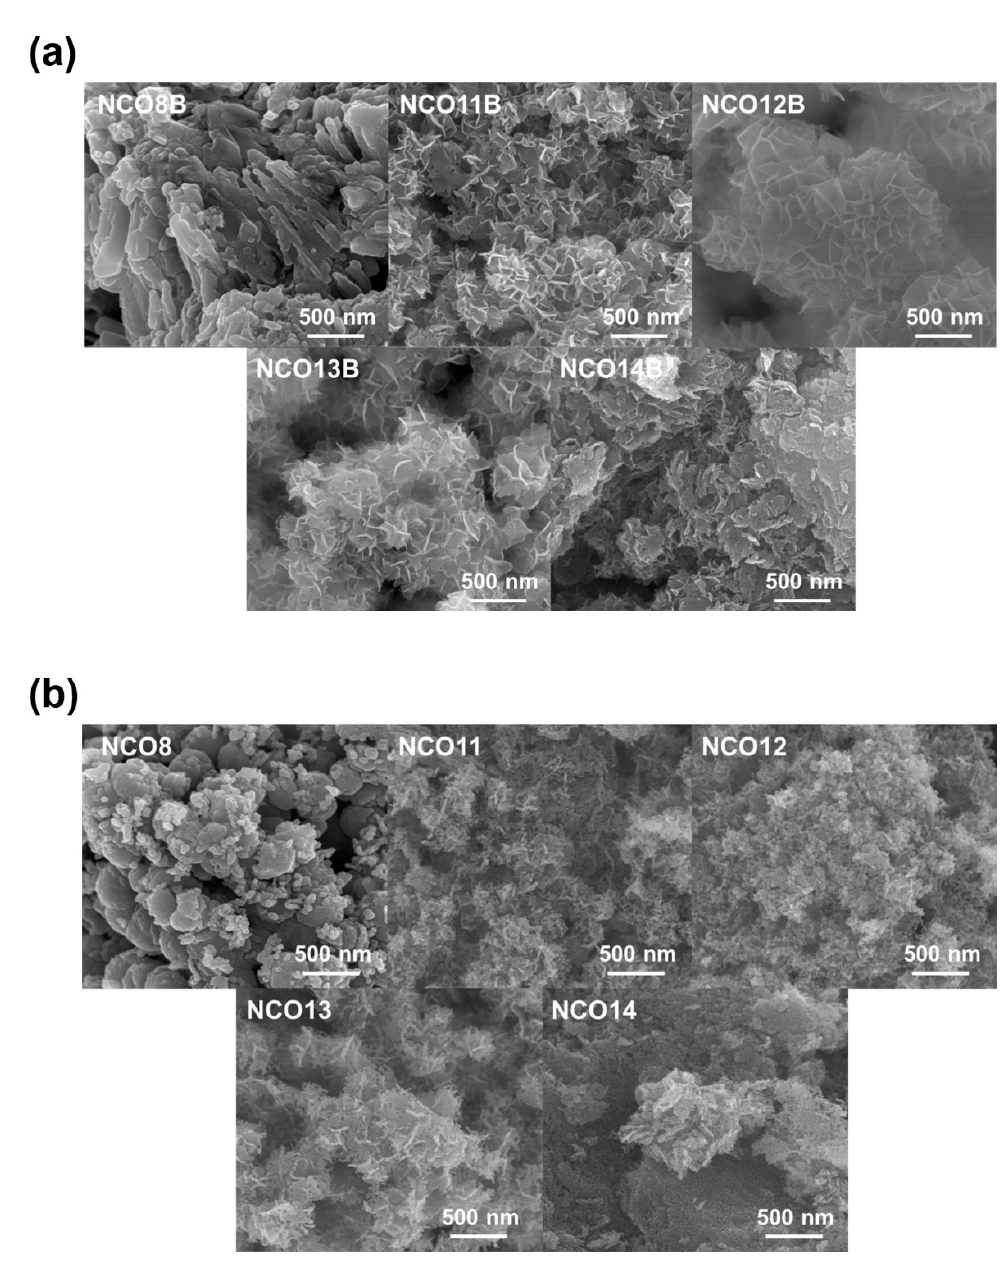
Figure 2. FE-SEM images of ( a ) NCOBs (8B, 11B, 12B, 13B, and 14B), and ( b ) NCOs (8, 11, 12, 13, and 14). Different microstructures of the NCOs can be determined by different processing conditions including pH, thus showing different electrochemical properties. The dependence of the cyclic voltammetric (CV) curves for NCOs on the pH during chemical bath synthesis was measured to investigate the electrochemical behavior of the NCOs under alkaline conditions (0.1 M NaOH) at various scan rates as shown in Figure 3. There is a negligible effect of pH on the redox peak potentials for the NCO electrodes. Regardless of pH, redox peak currents of the NCOs were increased with increasing CV scan rate. Oxidation peaks of the NCOs correspond to Ni 2+ /Ni 3+ , Co 2+ /Co 3+ , and Co 3+ /Co 4+ due to oxidation of Ni 2+ , Co 2+ and Co 3+ to Ni 3+ , Co 3+ , and Co 4+ , respectively. It is noted that the redox peak potential of Co 3+ /Co 4+ is close to that of Ni 2+ /Ni 3+ and Co 2+ /Co 3+ , which shows overlapped redox peaks in the CV curve [35–37]. In addition, the reduction peaks of NCOs are attributed to the Ni 3+ , Co 4+ , and Co 3+ to Ni 2+ , Co 3+ , and Co 2+ , respectively. The redox peak currents for the NCOs at the square root of the scan rates are presented